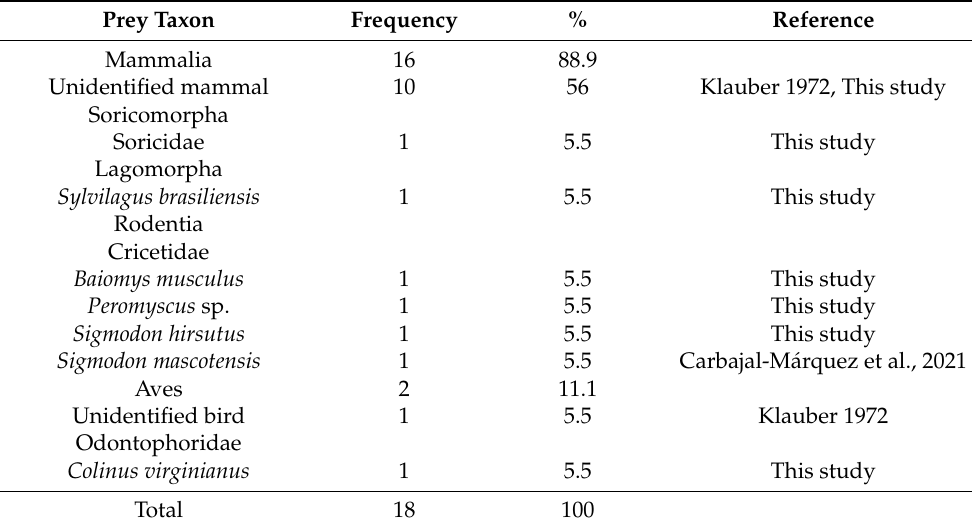
Table 1. Frequency and percentage of occurrence of the taxa that comprise the diet of Tehuantepec Isthmus rattlesnake ( Crotalus ehecatl ) from specimens analyzed in this study, from Klauber [6], and Carbajal-M á rquez et al. [9]. Prey